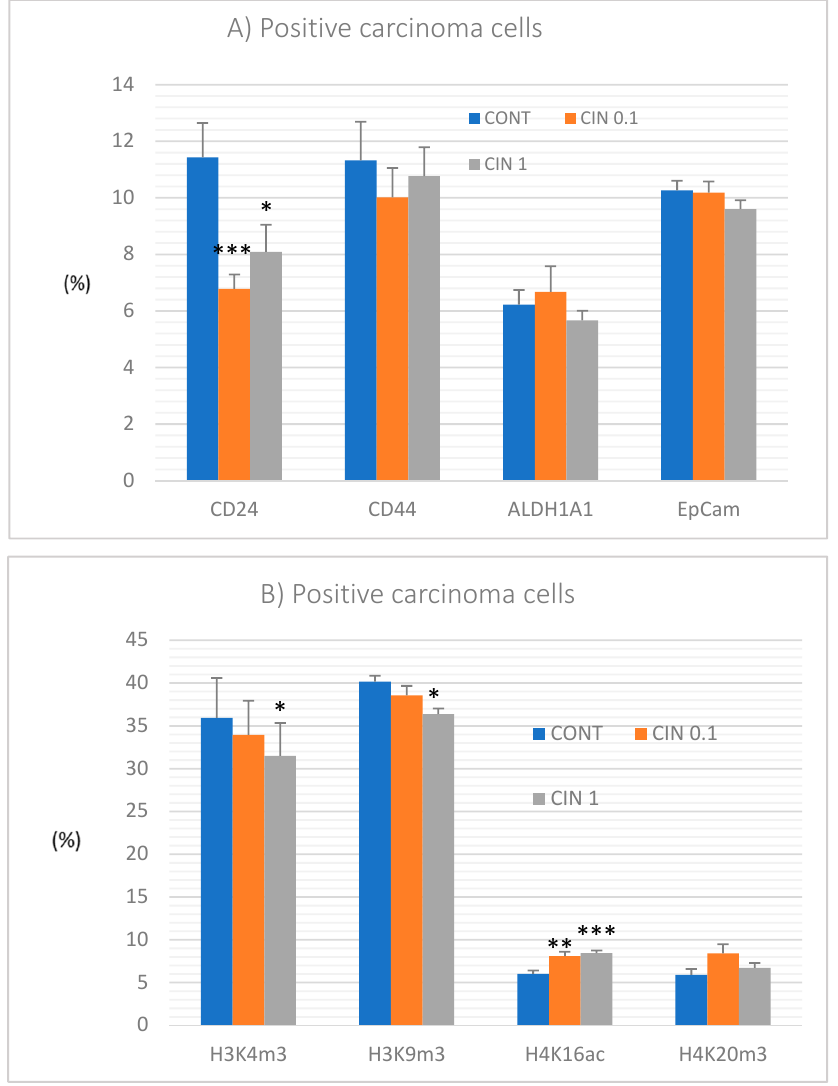
Figure 5. Immunoexpression of cancer stem cell ( A ) and epigenome ( B ) markers in rat mammary carcinoma cells after treatment with C. zeylanicum . Data are expressed as mean ± SEM. Significant difference: * p < 0.05, ** p < 0.01, *** p < 0.001 versus CONT. The values of protein expression were compared between treated (CIN 0.1, CIN 1) and non-treated (control) carcinoma cells of female rats; at least 60 images for one marker were analyzed.